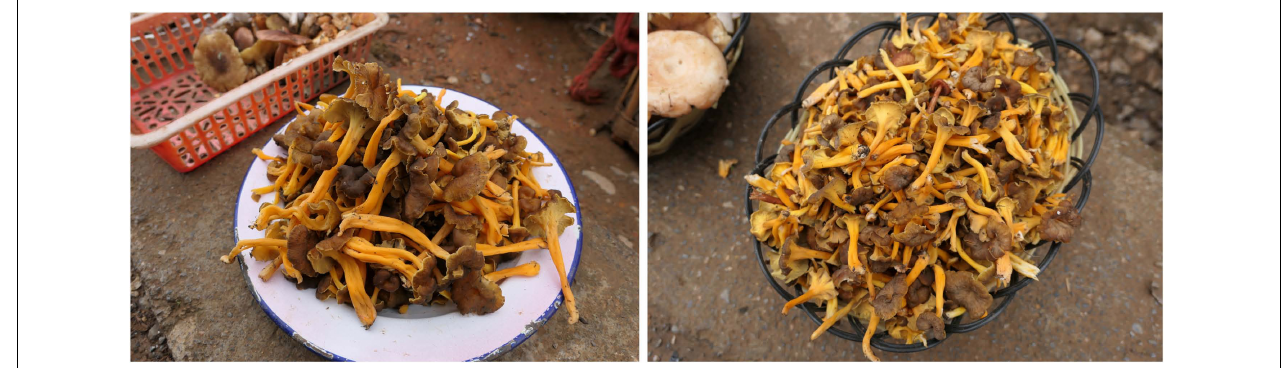
FIGURE 1 | Collections of Craterellus lutescens sold as edibles in the market of Yunnan Province, southwestern China. Photos: H.-Y. Huang.